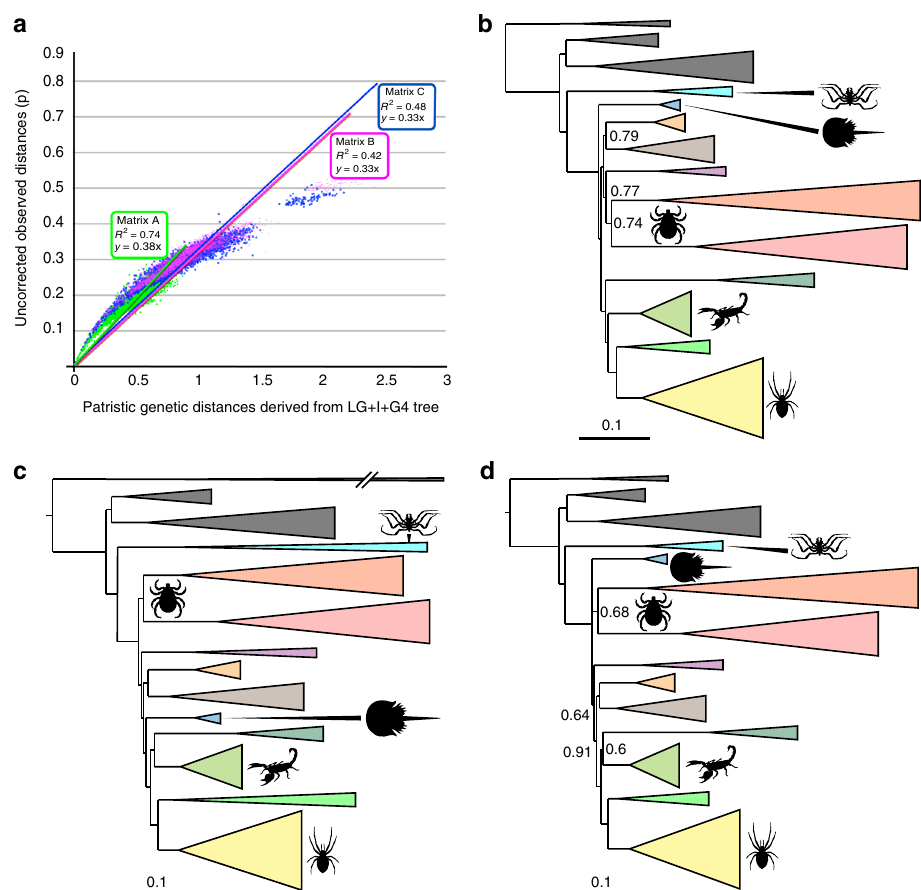
Fig. 1 Saturation plots and Bayesian results. a Saturation plots for Matrices A, B and C, illustrating that Matrix A has the lowest level of saturation. The dots represent the intersection between uncorrected genetic distances and the patristic distances obtained under ML for each pair of the 95 taxa. The lines of best fi t show the general trend and direction of the data and above is shown the R 2 and the slope of the regression line. Matrix A is represented in green, Matrix B in magenta and Matrix C in blue. Source data are provided as a Source Data fi le. b Schematic representation of the results of the CAT-GTR + G analysis of Matrix A. c Schematic representation of the results of the CAT-GTR + G analysis of Matrix B. d Schematic representation of the results of the CAT-GTR + G analysis of Matrix A, after Dayhoff-6 recoding. b – d Lineages are summarized at the ordinal level. Support values represent